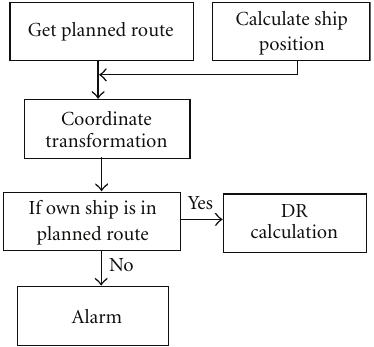
Figure 2: The simulation flow of route planning.